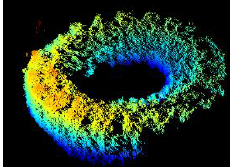
Figure 12. After removing the tire from the entire point cloud.